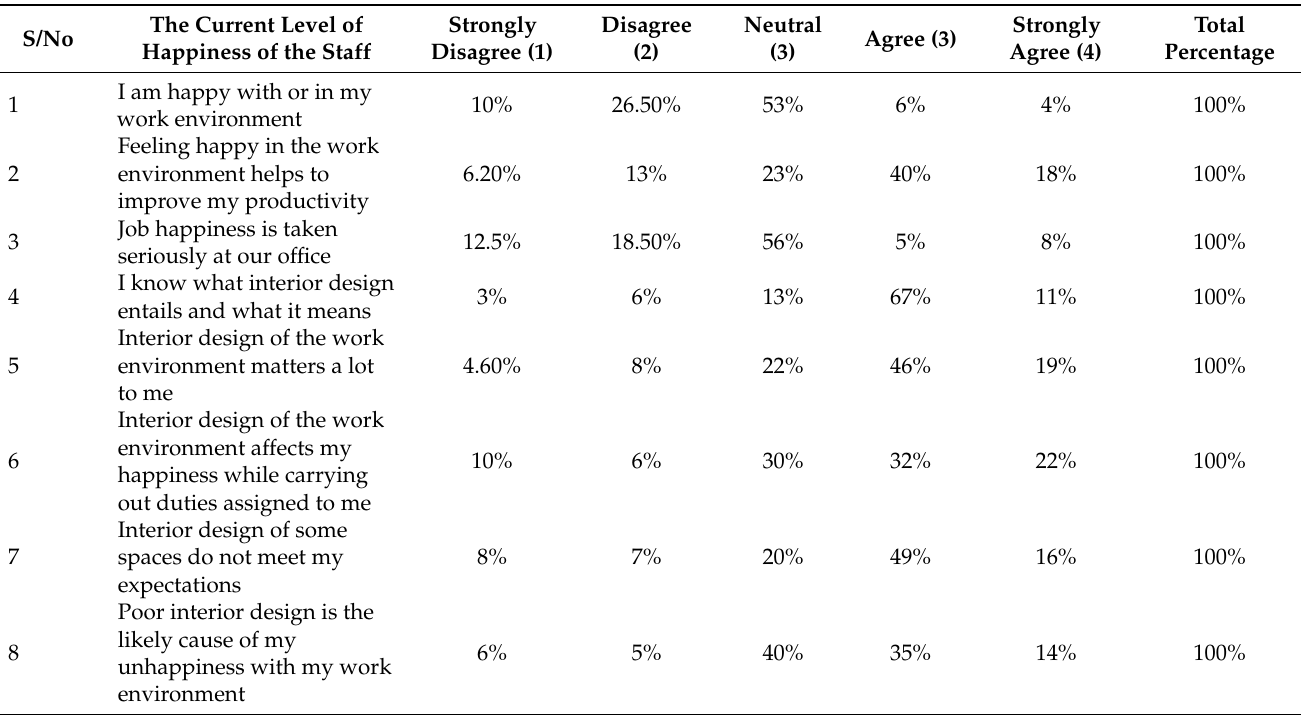
Table 1. The current level of happiness of the staff at Girls’ College of Science and Arts, King Khalid University, Saudi